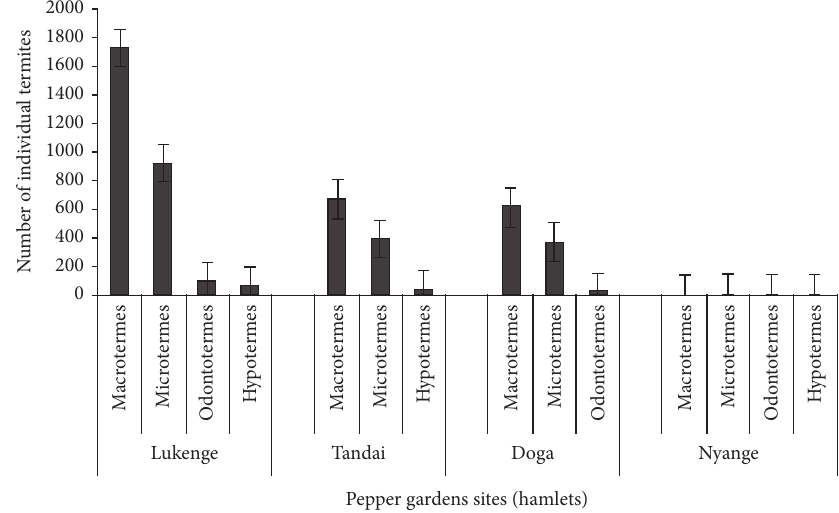
Figure 8: Termite species recorded from different pepper gardens in Tandai village. Table 4: Prevalence of spike shedding based on yield attributing